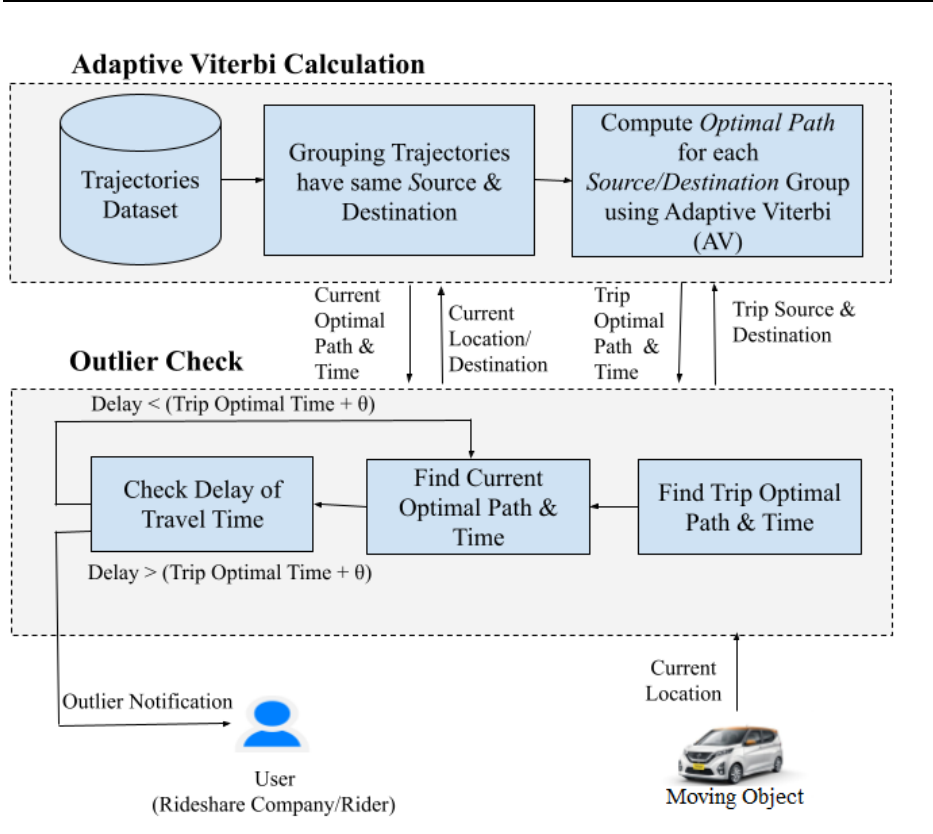
Figure 2. FraudMove